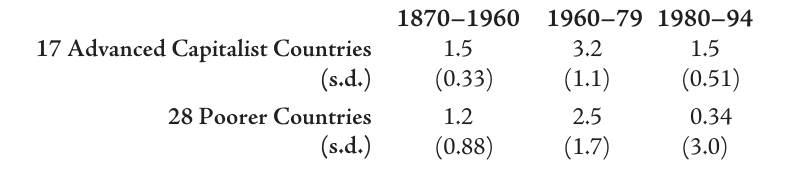
Table 1: Average Yearly Growth Rates in GDP Per